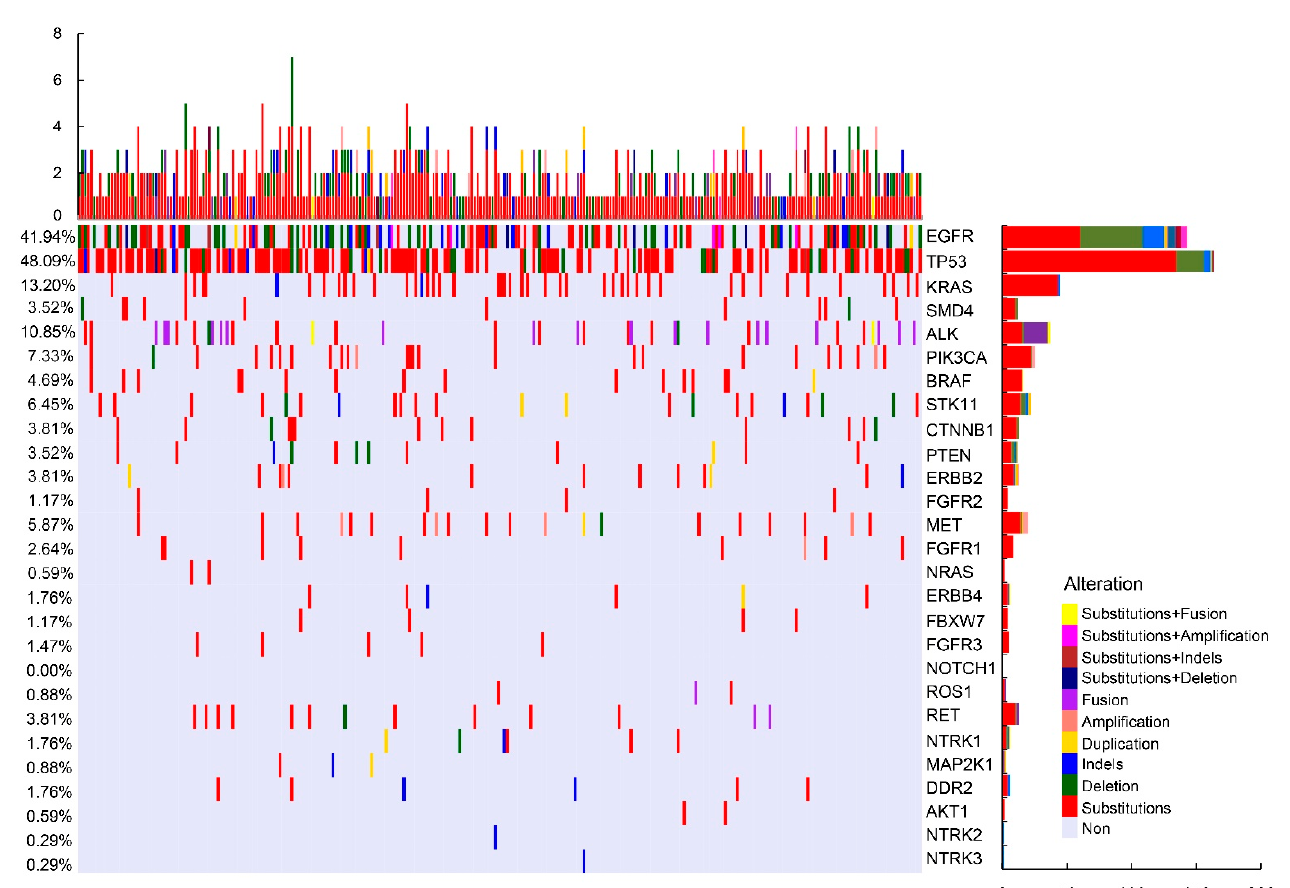
Figure 1. Mutation profile of the cohort. Each row represents a gene and each column represents a patient. The bar located at the bottom left denotes the mutation count of respective genes. Top plot represents the overall number of mutations that a patient carried. Different colors denote different types of mutations.